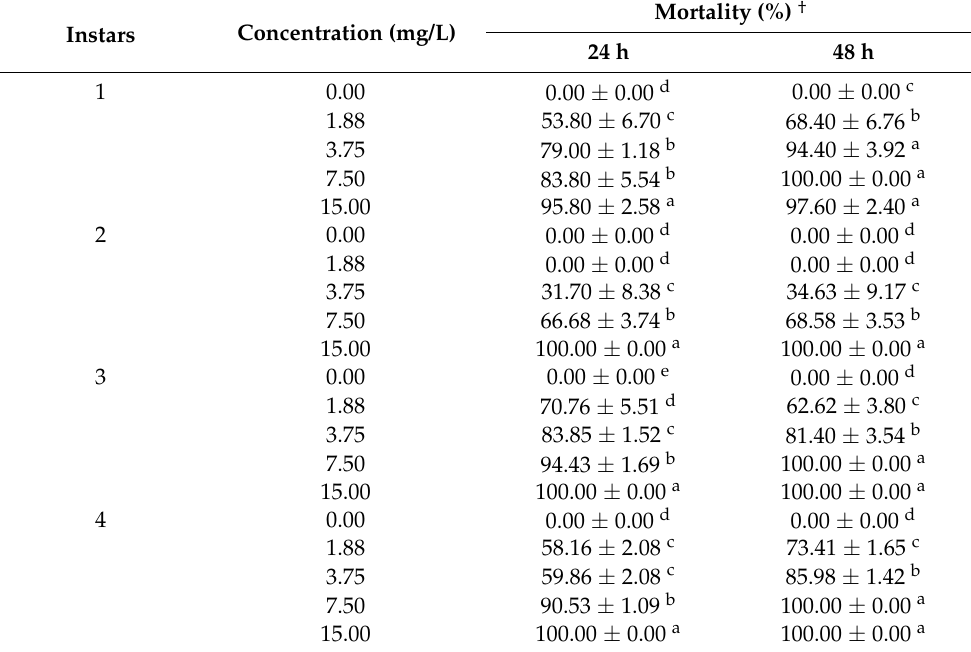
Table 1. Effects of different concentrations of Kathon on the mortality of larvae of C. quinquefasciatus in each instar.